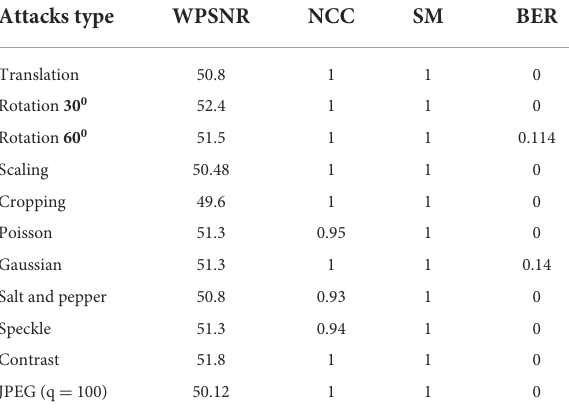
TABLE 1 Evaluation of different geometric attacks with their respective robustness